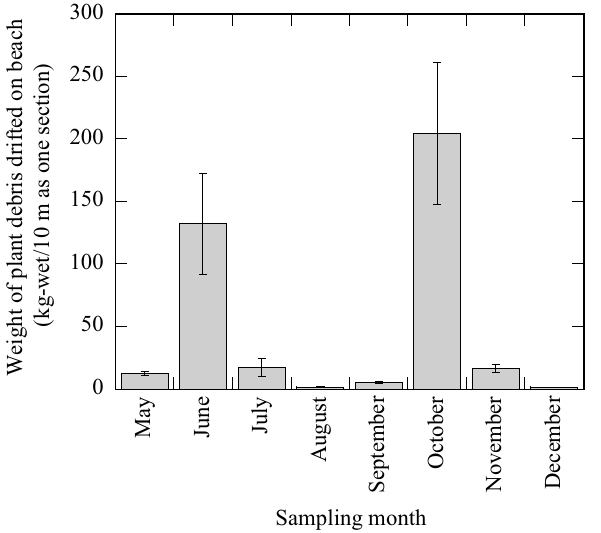
Figure 2. The monthly weight of plant debris accumulated on sections of Kizaki beach. Data shows the mean of three consecutive sections and error bars represent standard deviations